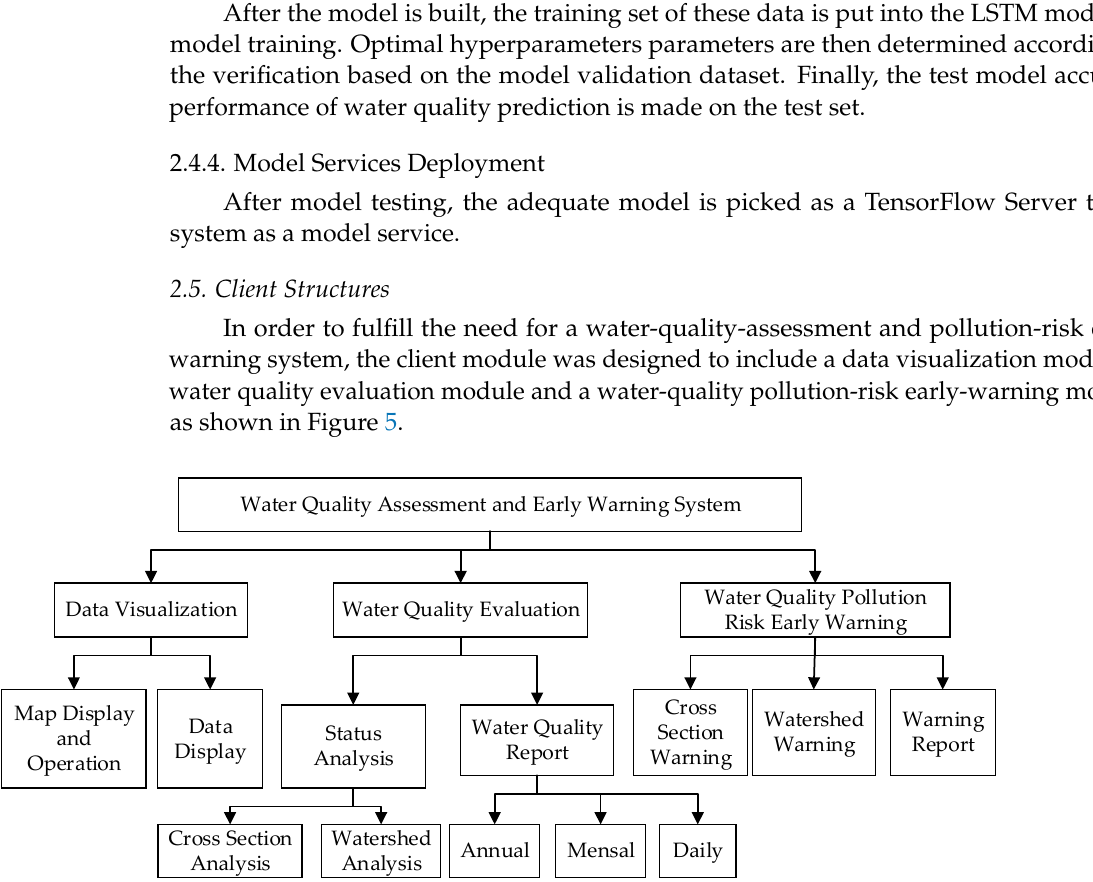
Figure 5. The submodules and functions designed in the